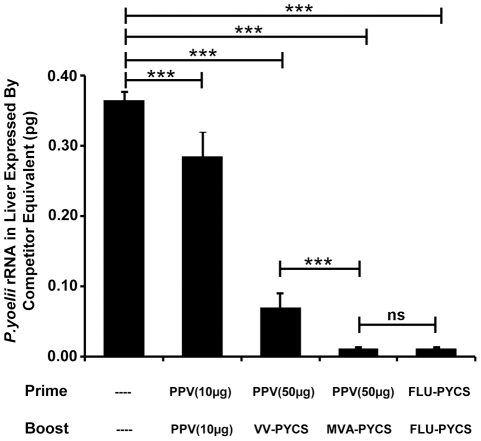
Protection against malaria after prime/boost with PPV-PYCS/MVA-PYCS protocol.Groups of BALB/c mice (5 per group) were immunized with different amounts of PPV-VLPs [PPV(10 µg) and PPV(50 µg)] and two weeks later animals were boosted with the replication restricted MVA-PYCS or the replication competent VV-PYCS. A positive control group primed with an influenza virus recombinant expressing the CD8+ T cell epitope and booster with VV-PYCS, a protocol previously shown to induce high protection against the parasite, was included [10]. Thirteen days later, animals were challenged with sporozoites and the amount of parasite rRNA in the liver of each animal was estimated 42 h after the challenge, as described under Materials and Methods. Results are expressed as the mean with standard deviation. Statistical values were determined by one-way ANOVA; P values, *P<0.05, **P<0.01, ***P<0.001.